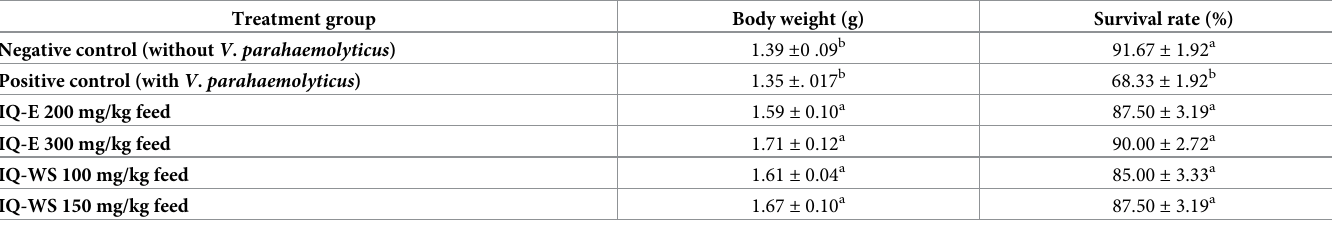
Table 5. Effects of IQ extracts on growth performance and survival rate of the Vibrio parahaemolyticus -infected shrimp. Treatment